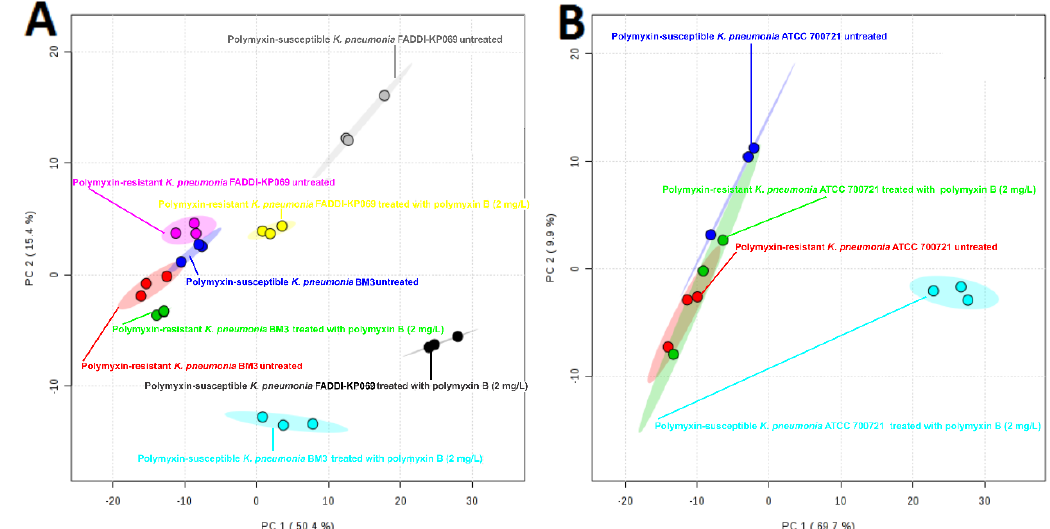
Figure 1. Principal component analysis (PCA) score plot for OMVs isolated from polymyxin-susceptible and -resistant K. pneumoniae isolates. ( A ) PCA score plot for the two clinical isolates. Polymyxin-resistant K. pneumoniae BM3 untreated (red); polymyxin-resistant K. pneumoniae BM3 treated with polymyxin B (2 mg/L) (green); polymyxin-susceptible K. pneumoniae BM3 untreated (blue); polymyxin-susceptible K. pneumoniae BM3 treated with polymyxin B (2 mg/L) (cyan); polymyxin-resistant K. pneumoniae FADDI-KP069 untreated (purple); polymyxin-resistant K. pneumoniae FADDI-KP069 treated with polymyxin B (2 mg/L) (yellow); polymyxin-susceptible K. pneumoniae FADDI-KP069 untreated (grey); polymyxin-susceptible K. pneumoniae FADDI-KP069 treated with polymyxin B (2 mg/L) (black). ( B ) PCA score plot for the paired K. pneumoniae ATCC 700721 laboratory type isolates. Polymyxin-resistant K. pneumoniae ATCC 700721 untreated (red); polymyxin-resistant K. pneumoniae ATCC 700721 treated with polymyxin B (2 mg/L) (green); polymyxin-susceptible K. pneumoniae ATCC 700721 untreated (blue); polymyxin-susceptible K. pneumoniae ATCC 700721 treated with polymyxin B (2 mg/L) (cyan). Each data point represents three biological replicates.